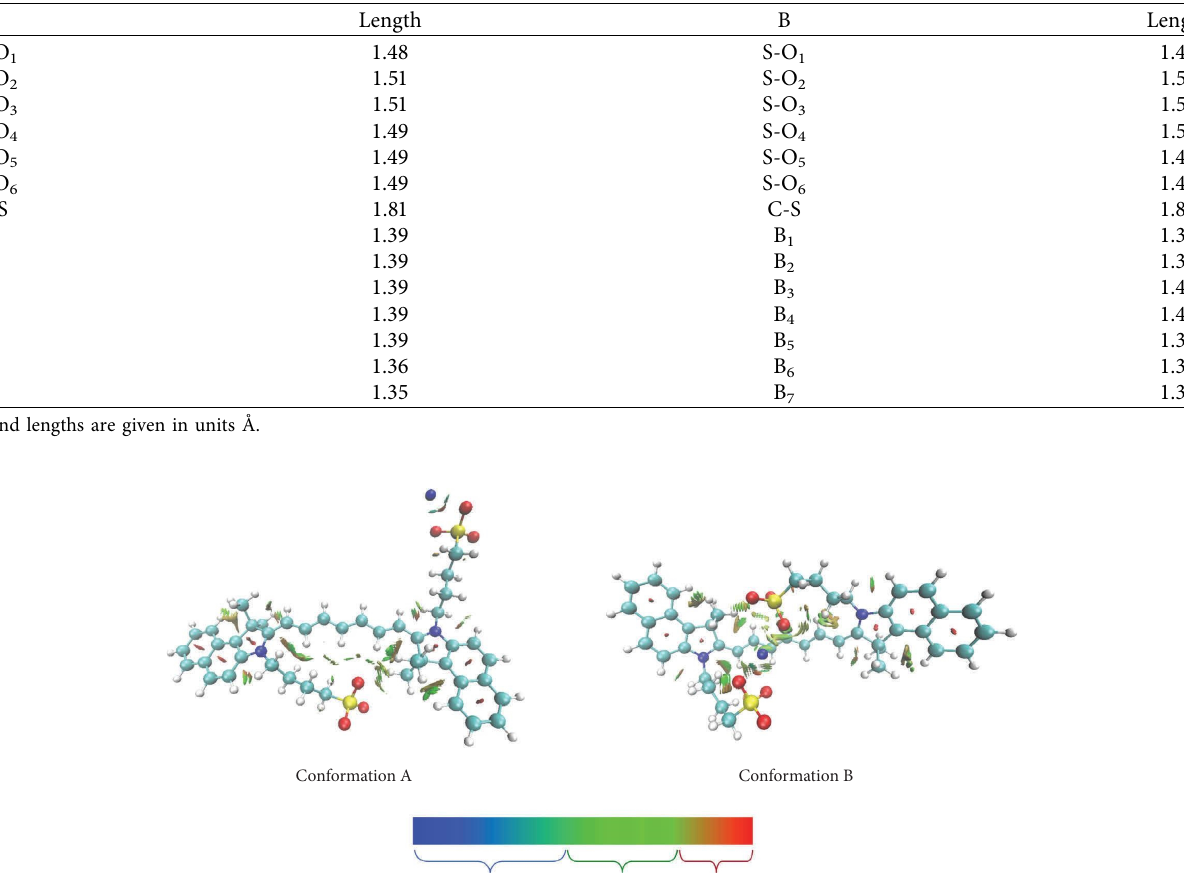
Table 2: Te bond lengths of the main bonds belong to the two conformations of the IGC molecule 1 .